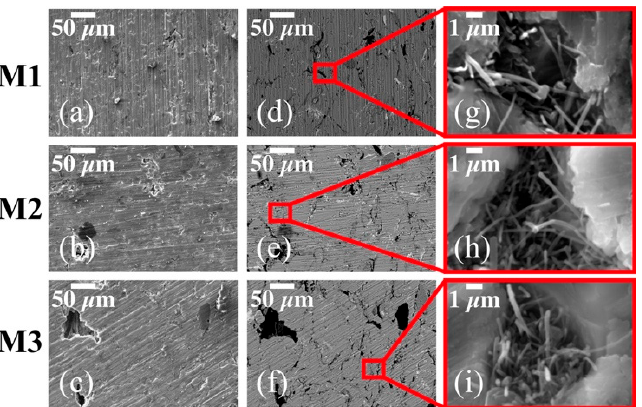
Figure 2. Cross-sectional SE-SEM ( a – c ) and BSE-SEM ( d – f ) micrographs for sintered nanocomposites M1, M2 and M3 reinforced with multi-walled carbon nanotubes (MWCTNs) at 0.5 wt% 1 wt% and 2 wt%, respectively. The MWCNTs agglomerations observed in ( g – i ) are located in the grain boundary of the Al matrix.